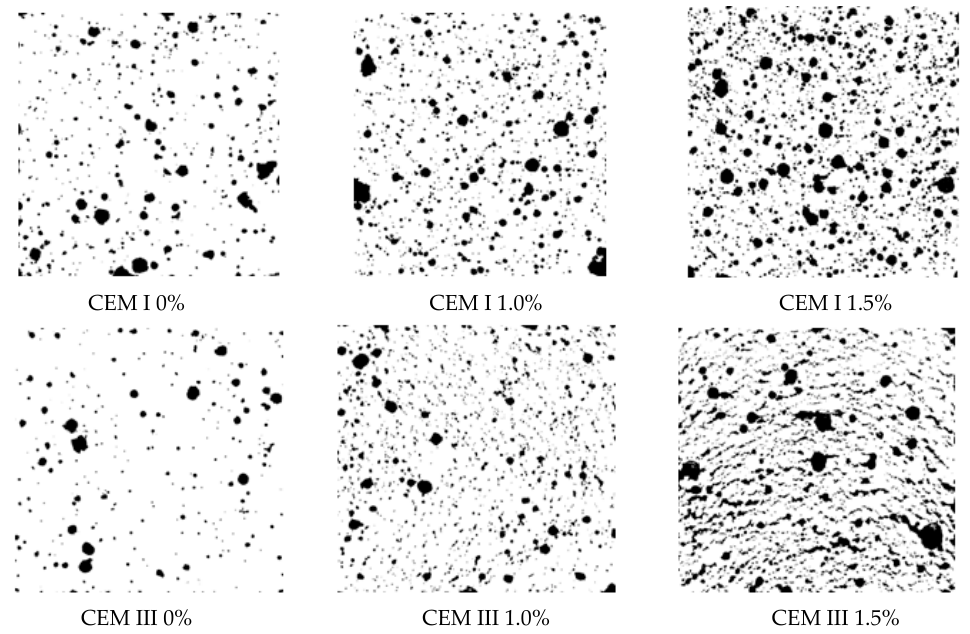
Figure 5. Images of sample cross-sections of mortars after preparation for image analysis. The porosity of the mortar with CEM III cement without admixture was about 40% lower than the porosity of the mortar with Portland cement. Addition of 1% of admixture caused an increase in the number of spherical pores of mortar with CEM III cement, which resulted in a more than 2-fold increase in mortar porosity. After increasing the amount of admixture to 1.5% of the CEM III cement mass, porosity increased more than four times (from 4.24% to 18.4%) compared to the mortar without admixture. Stratification of the sample of CEM III cement mortar with 1.5% of admixture was observed due to the pres- sure exerted by the hydrogen gas created after the loss of plasticity of the fresh mortar. The increase in admixture content caused the increase in S V of the mortar with both CEM I and CEM III (Table 3), which is associated with the appearance of new pores. The S V parameter increased about 67% and 162%, respectively, after the addition of 1.0% and 1.5% of gas-liberating admixture to CEM I mortar. While the modification of CEM III mor- tar with the same amount of admixture resulted in an increase in S V above 2-fold (about 227%) and about 5-fold (about 500%), respectively. The more intensive increase in S V of CEM III mortar in comparison to CEM I mortar may be explained by a greater number of small pores introduced to slag cement mortar as a result of the modification. The results of the relative surface area of pores confirm findings concerning the relative volume of pores. Table 4. Parameters of pore structure calculated by the computer image analysis method. Mortar